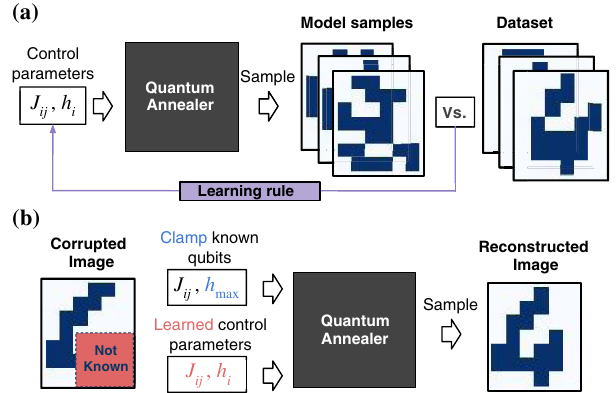
FIG. 1. Quantum-assisted unsupervised learning. (a) During the training phase, samples generated by the quantum annealer are compared with samples from the data set of, say, black-and- white images. The control parameters are then modified accord- ing to a learning rule (see Sec. III). This process is iterated a given number of times, also known as epochs. (b) After being trained, we can use the quantum annealer, for instance, to reconstruct missing information in a data point, e.g., unknown values of some pixels (red region). To do this, we program the quantum annealer with the control parameters learned, except for the fields of those qubits that represent known pixels. These fields are instead set to large values h , so the qubits are clamped to the known values max of the corresponding pixels. We then generate samples to infer the values of the unknown